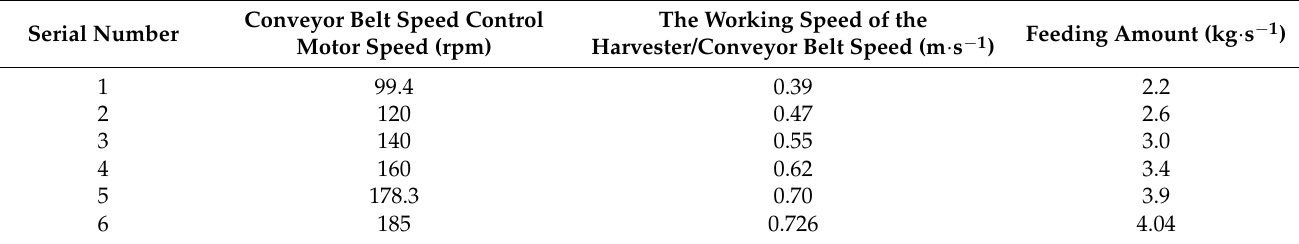
Table 2. Relationship calibration between feed amount and transmission velocity.